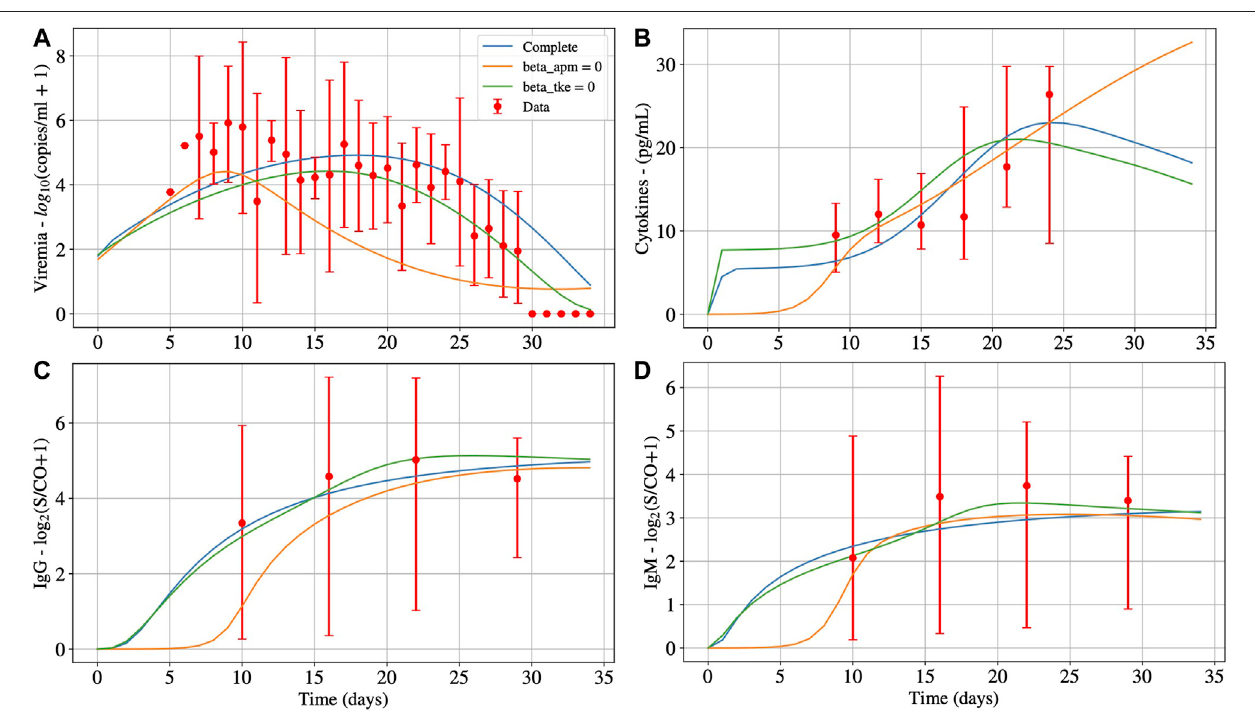
FIGURE4| Deterministicnumericalsolutionof Eqs1 , 15 , 14 and 13 forthenon-survivorscaseconsideringthreehypothesis:1)InfectionofbotheffectorAPCsand CD8 + T cells (complete, with β apm ≠ 0 and β tke ≠ 0); 2) Infection of CD8 + T cells only ( β apm (cid:1) 0); and 3) Infection of effector APCs only ( β tke (cid:1) 0). Panels A, B, C and D present the results for viremia, cytokines, IgG and IgM, respectively.